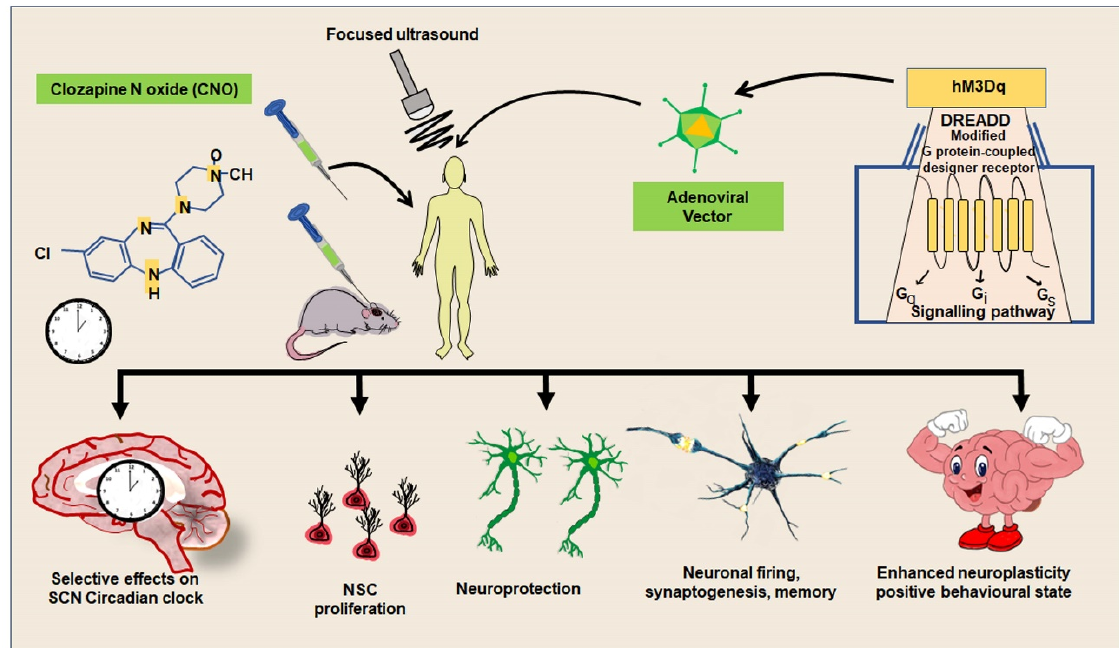
Figure 4. The regulation of neuronal activity by chemogenetics.